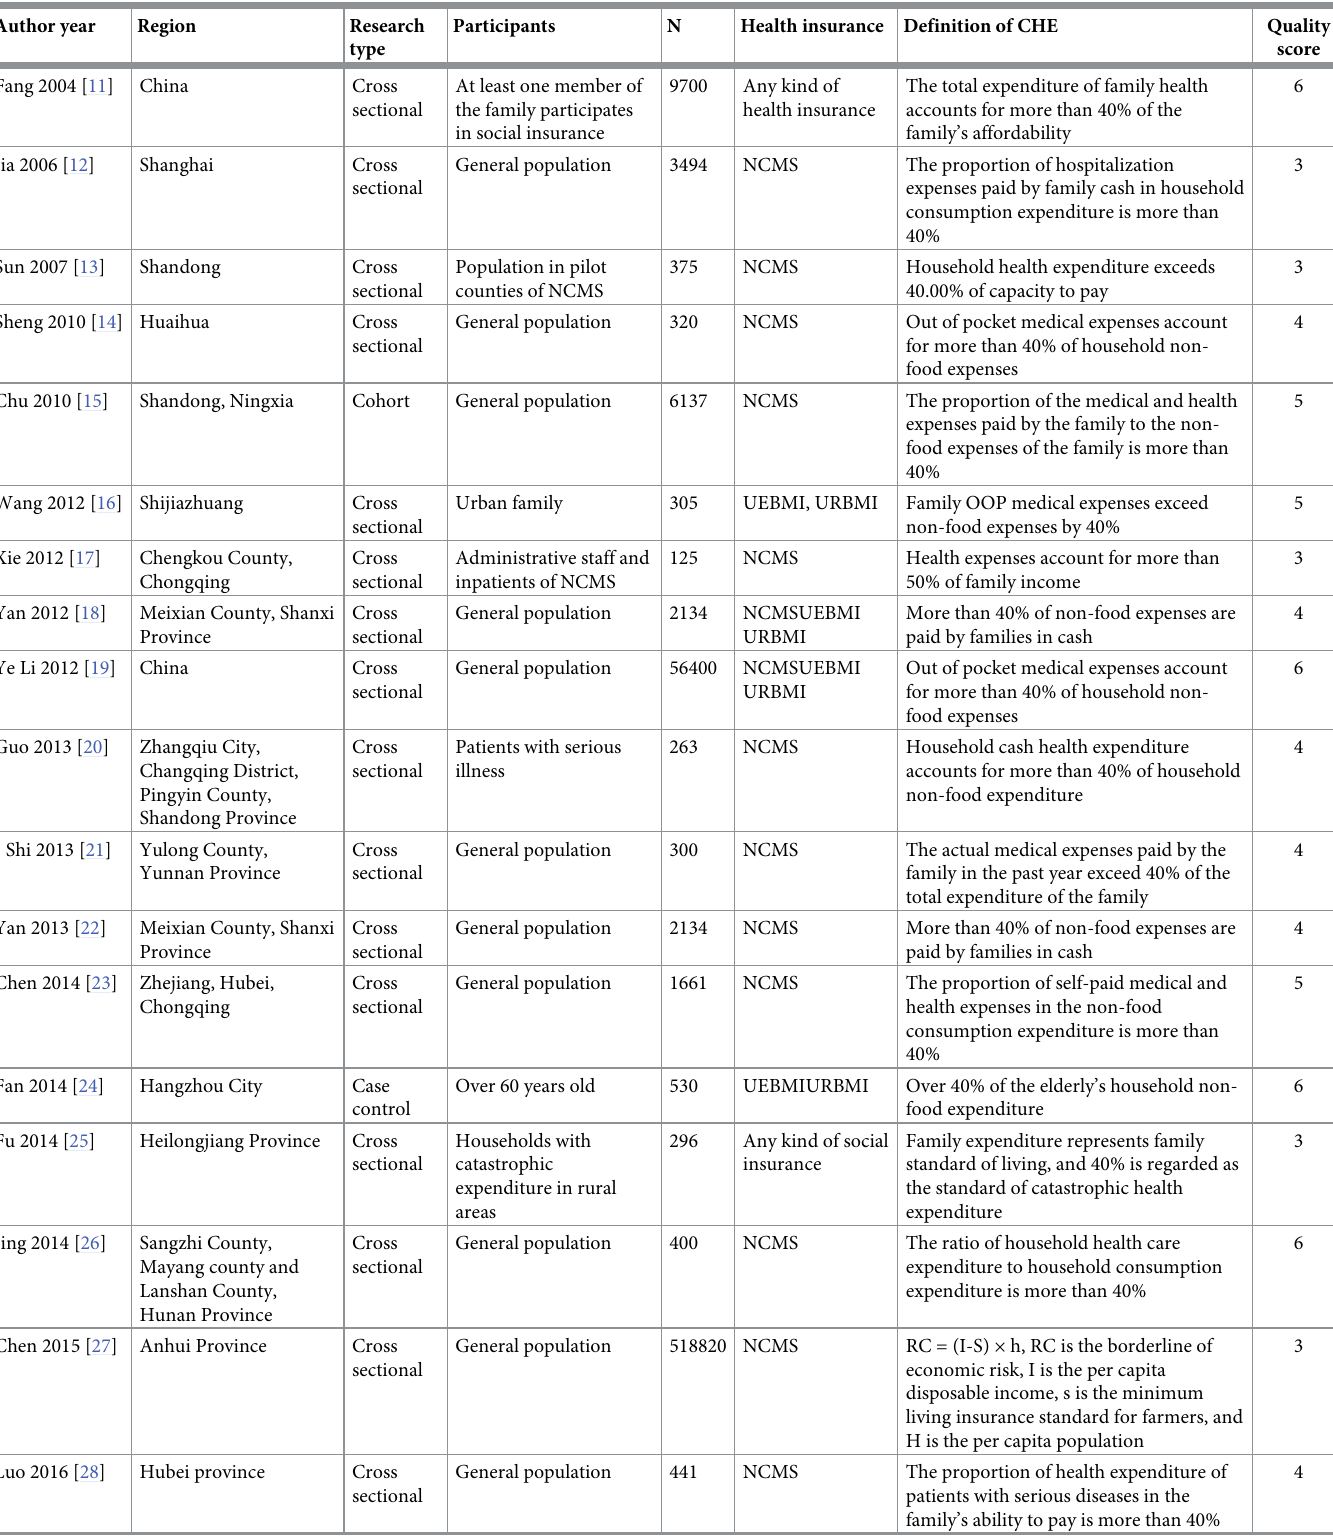
Table 1. Characteristics of included